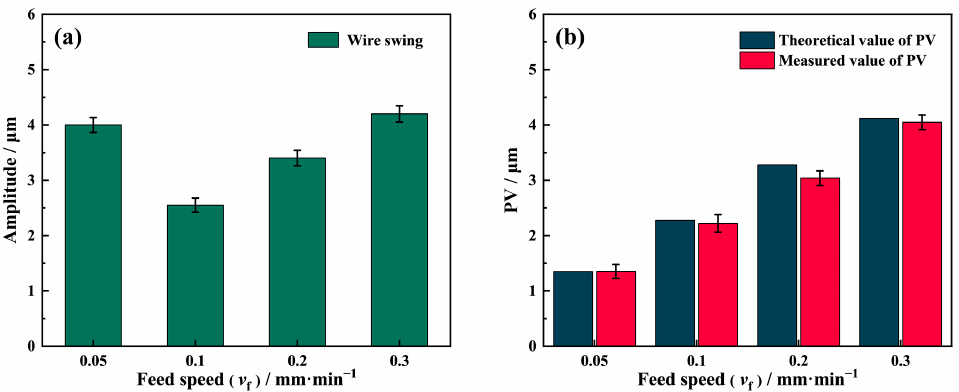
Figure 11. ( a ) Wire swing and ( b ) the comparison of theoretical and measured PV